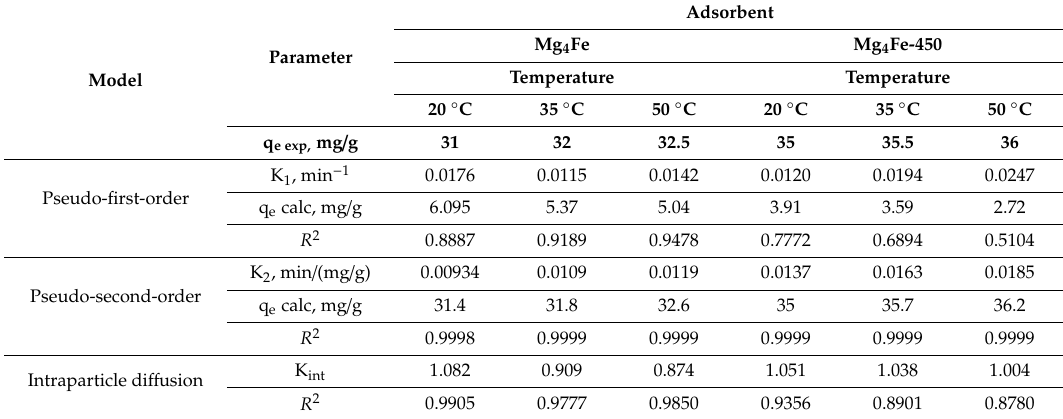
Table 4. Kinetic model parameters for Mo(VI) adsorption onto Mg 4 Fe and Mg 4 Fe-450.